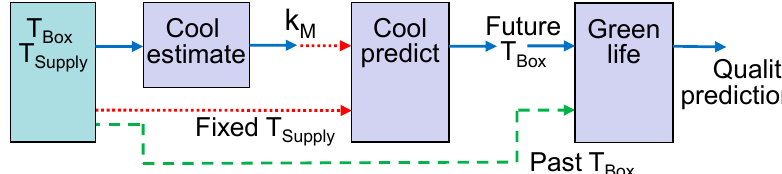
Figure 4. Prediction of future temperature and green life after operator query.